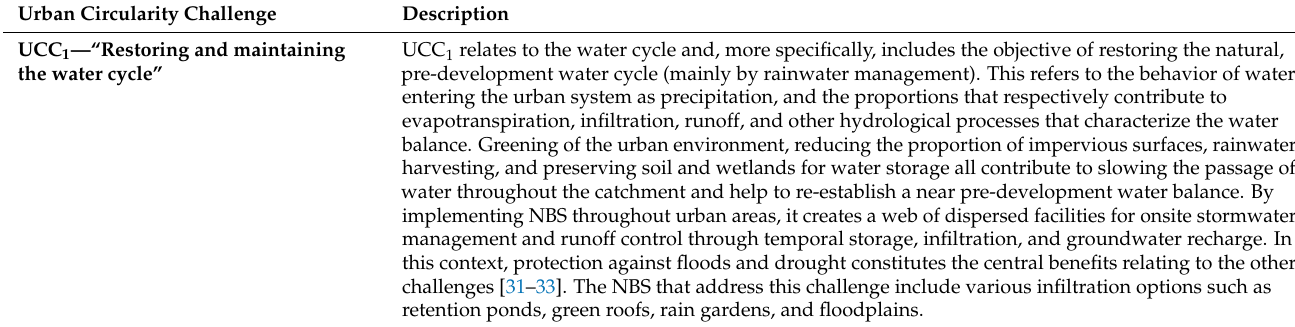
Table A1. Descriptions of Urban Circularity